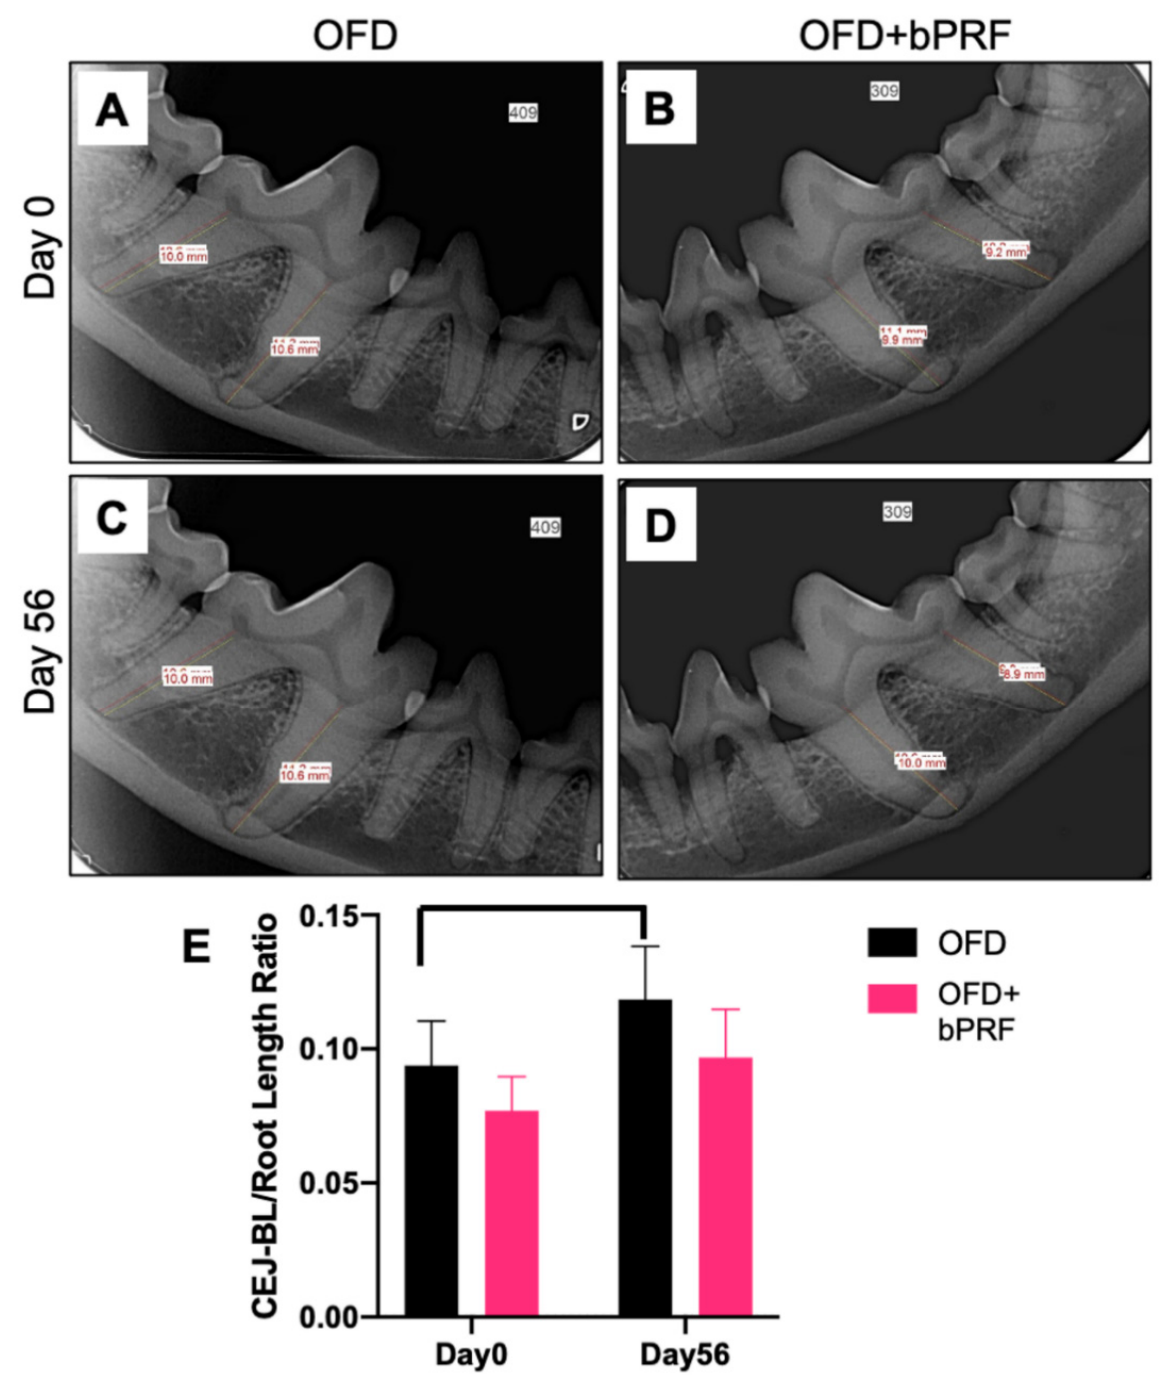
Figure 3. Bubaline blood-derived platelet-rich fibrin (bPRF) did not affect alveolar bone regeneration. Radiographic images were performed to evaluate alveolar bone regeneration. Representative radiographs demonstrated the levels of alveolar bone in the OFD and OFD+bPRF groups at baseline ( A , B ) and day 56 after intervention ( C , D ). The proportional distance between cemento-enamel junction (CEJ) and alveolar margin (AM) relative to root length was calculated ( E ). OFD; open-flap debridement-treated group, OFD+bPRF; open-flap debridement and bubaline blood-derived platelet-rich fibrin-treated group. Bars indicate a statistically significant difference.